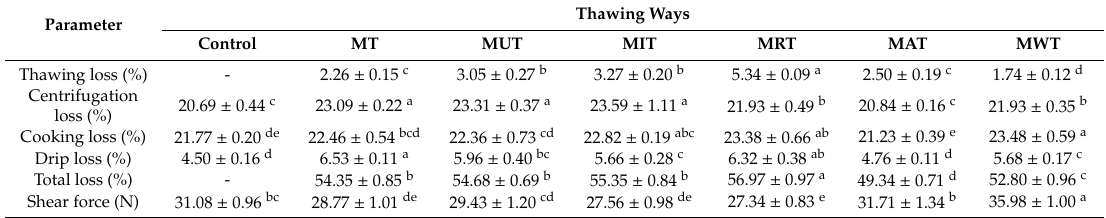
MT: Microwave thawing (100 W); MUT: Microwave combined with ultrasonic thawing; MIT: Microwave combined with 35 ◦ C water immersion thawing; MRT: Microwave combined with 4 ◦ C refrigeration thawing; MAT: Microwave combined with air convection thawing; MWT: Microwave combined with running water thawing. Data are means ± SE. a–d values in the same row followed by di ff erent letters are significantly di ff erent according to Duncan’s multiple range test ( p <